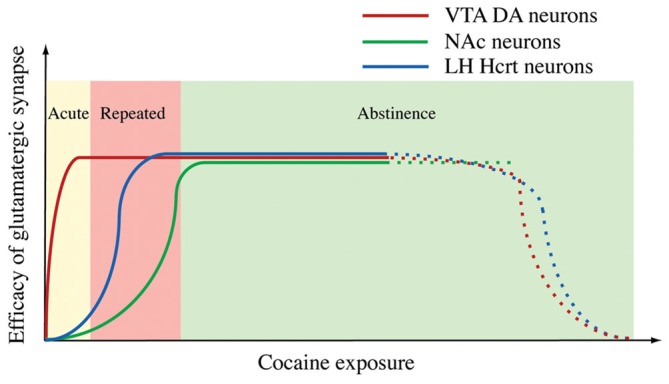
A diagram summarizes the time courses of synaptic potentiation in the ventral tegmental area (VTA) (Ungless et al., 2001), NAc (Kourrich et al., 2007) and Hcrt neurons induced by exposure to cocaine. From Rao et al. (2013) with permission from Journal of Physiology.